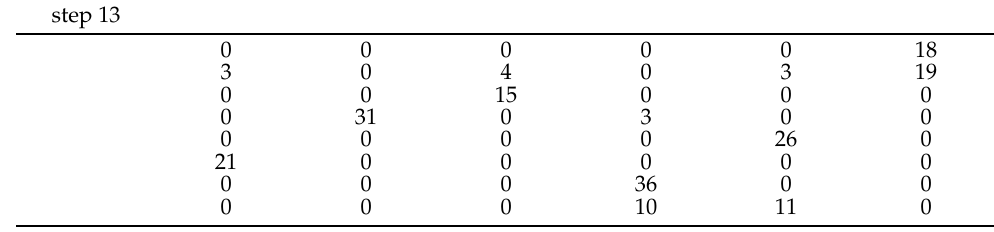
Table 6. Results of subsequent iterations and feasible solution for least cost in matrix method.